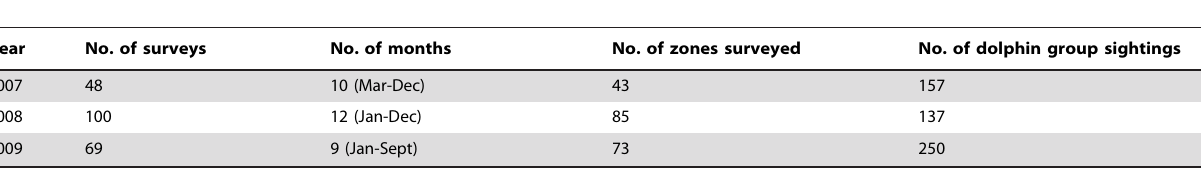
Table 2. Summary of annual survey effort across months and number of zones surveyed between March 2007 and November 2009.